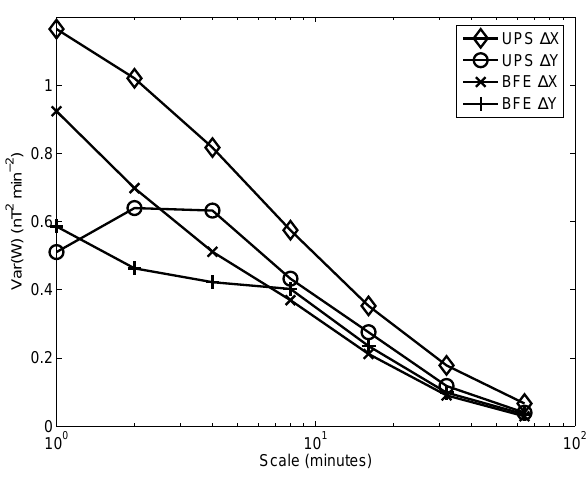
Fig. 1. The figure shows the power distribution of 1X and 1Y at Brorfelde (BFE), Denmark, and Uppsala (UPS), Sweden, based on 525600 one-minute data points from 1998. 1X and 1Y are the one-minute time differences of the north-south and east-west magnetic field components,